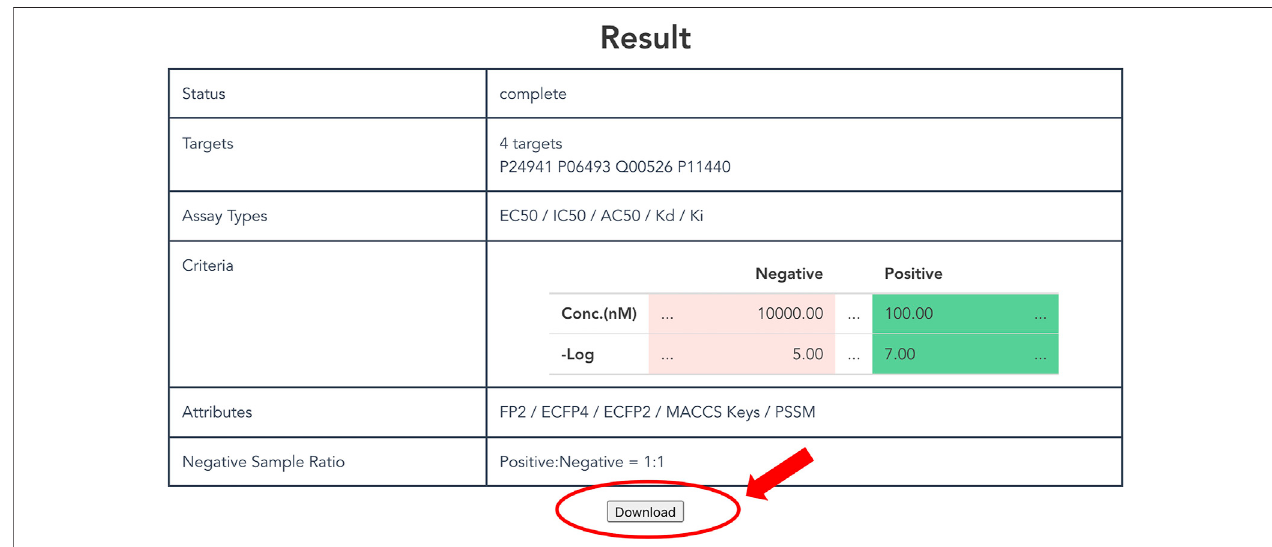
FIGURE 4 | Display of result page. The result page shows the progress of the submitted dataset generation job and the input parameters speci fi ed by the user. A “ Download ” button appears at the bottom of this page when the job is completed, allowing the user to download the